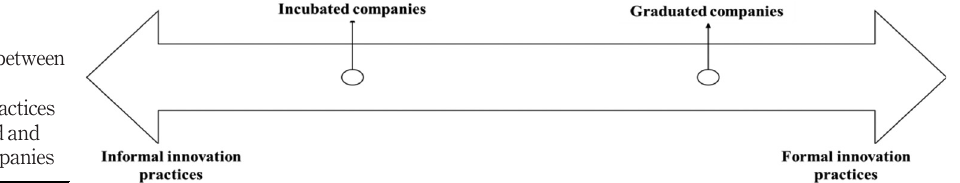
Figure 1. Relationship between formality in innovation practices and incubated